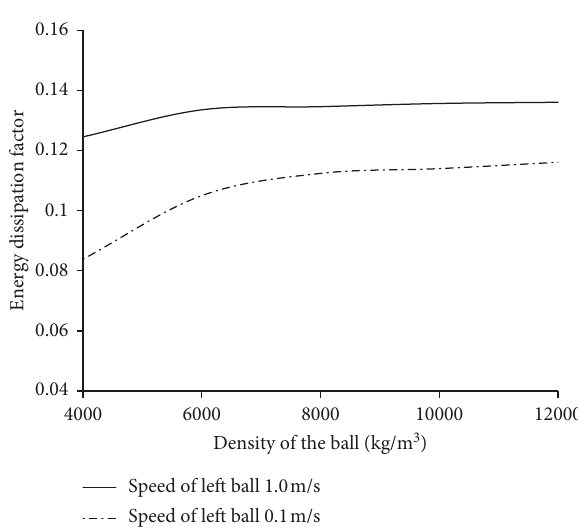
Figure 11: Curve of the energy dissipation factor under different densities.